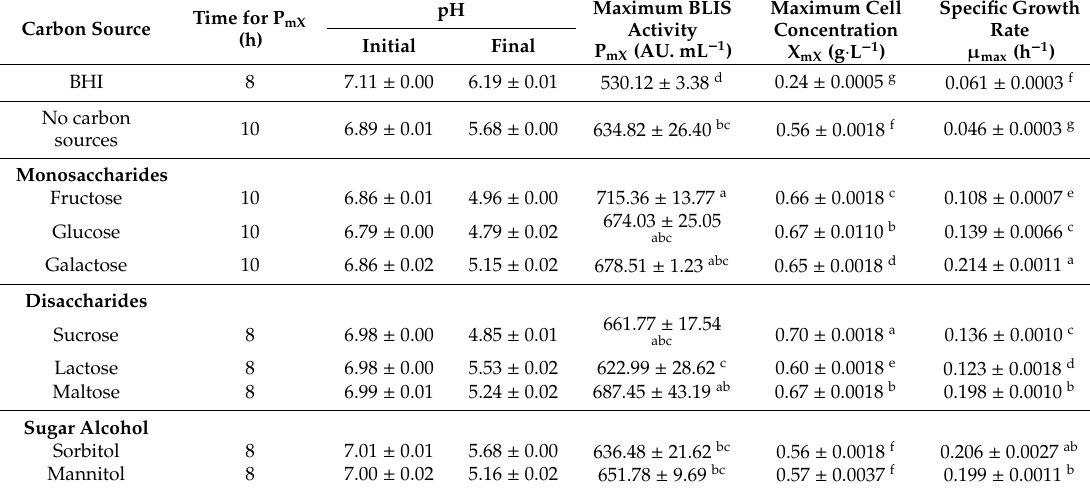
Table 8. Growth of L. lactis Gh1 and BLIS production by using modified BHI medium supplemented with 4.6 g / L N of soytone at di ff erent carbon sources. All carbon sources were added at 2 g / L. Carbon